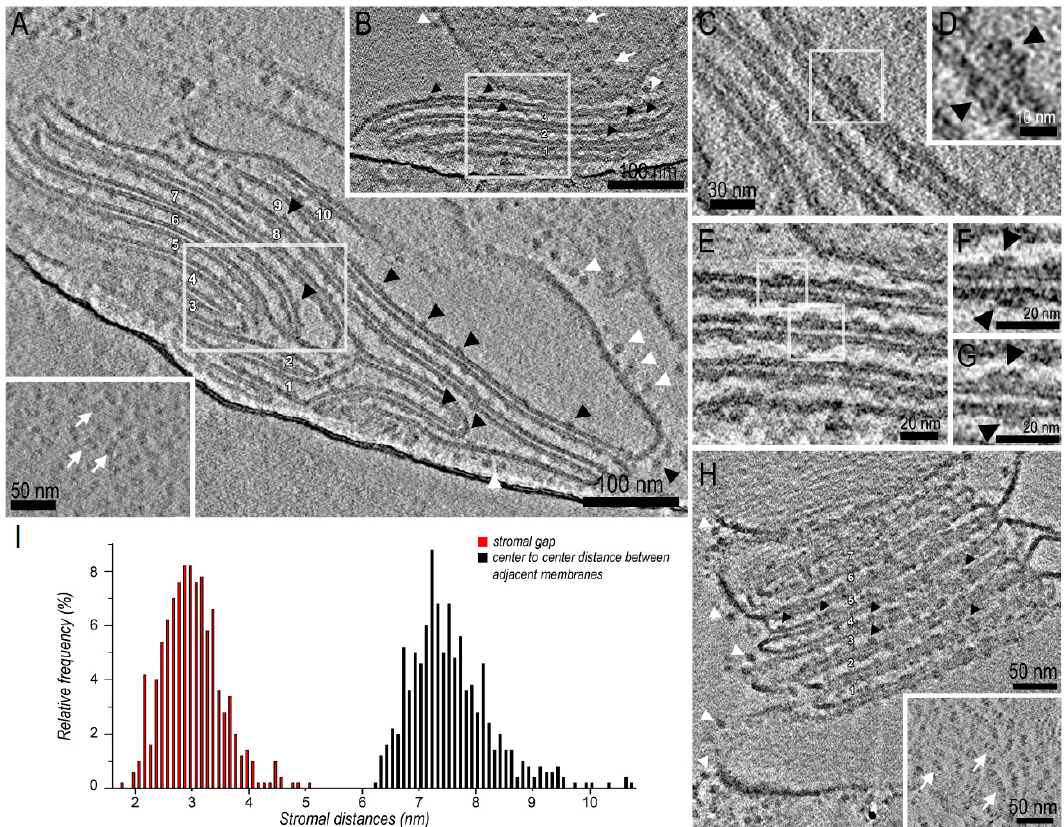
Figure 2. Cryo-electron tomography of isolated stacked thylakoid membranes. ( A ) Average tomographic slice of a stack of 10 thylakoid membranes in side view. The inset shows a tangential averaged tomographic view of a thylakoid membrane. ( B ) Higher magnification of the boxed region in A in a slightly different tomographic section. ( C ) Higher magnification of the boxed region in B showing a paired PSII-LHCII supercomplex in two adjacent thylakoid membranes. ( D ) Average tomographic slice of a stack of 3 thylakoid membranes in side view. ( E ) Higher magnification of the boxed region in ( D , F , G ) are higher magnifications of the boxed regions in E showing paired PSII-LHCII supercomplexes in two adjacent thylakoid membranes. ( H ) Average tomographic slice of a stack of 7 thylakoid membranes in side view. The inset shows a tangential averaged tomographic view of a thylakoid membrane. ( I ) Distributions of stromal gap (red) and center-to-center distances (black) between adjacent thylakoid membranes across the stromal gap. In the figure, white and black arrowheads point respectively to the ATP-synthase complexes protruding from the grana end membranes and to the extrinsic subunits of PSII protruding into the lumen; white arrows point to PSII-LHCII supercomplexes.